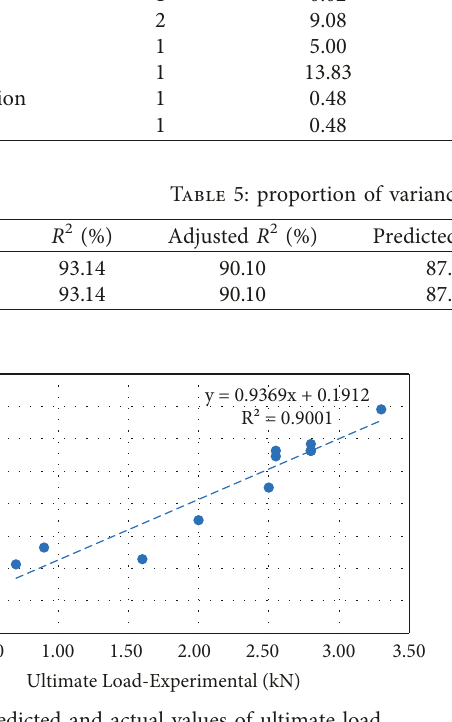
Figure 5: Predicted and actual values of ultimate